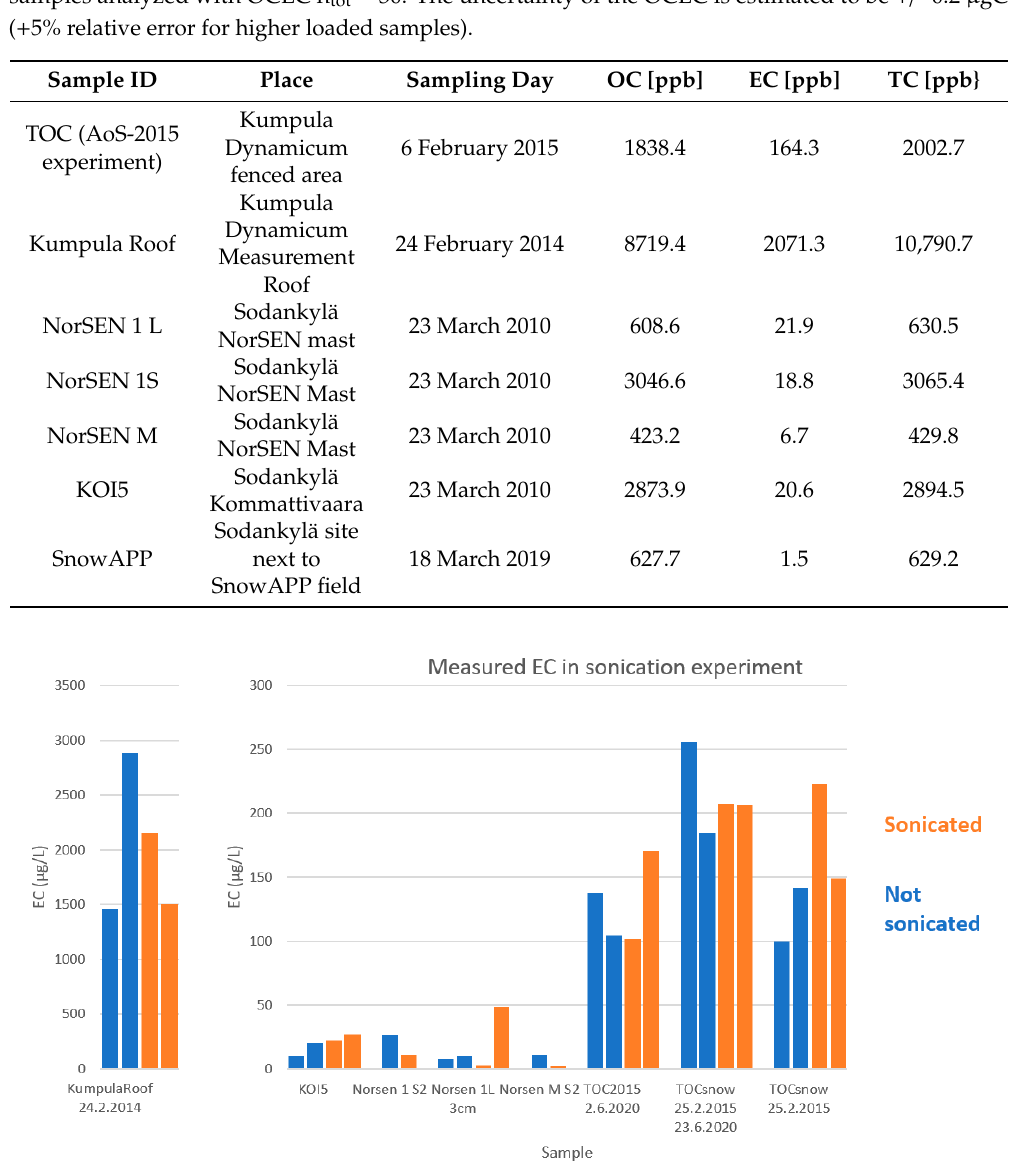
Figure 3. The elemental carbon (EC) results of the sonication experiment in a pairwise comparison of the sonicated and non-sonicated